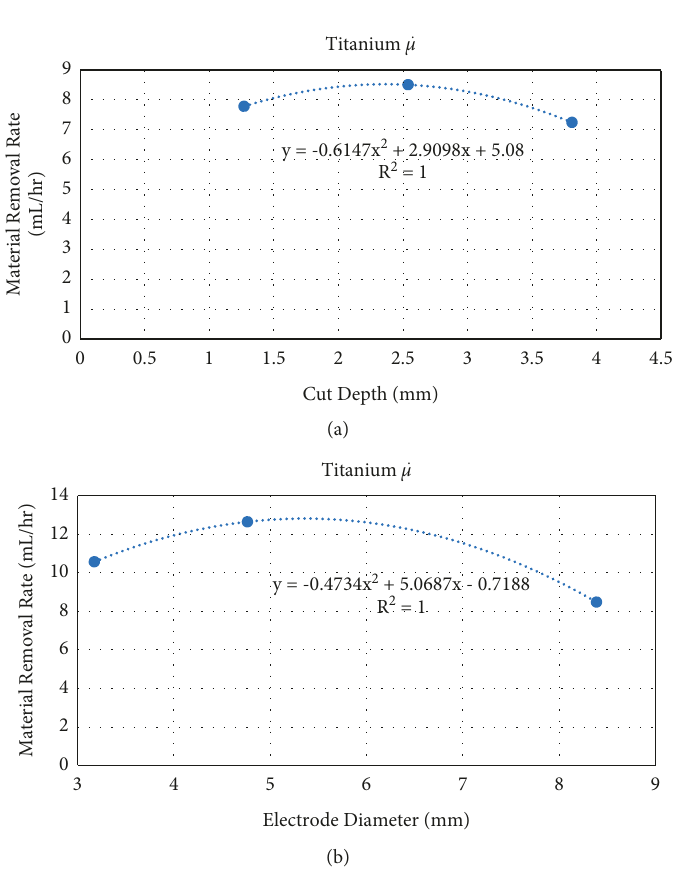
Figure 9: Mean _ μ due to cut depth (a) and electrode diameter (b) in